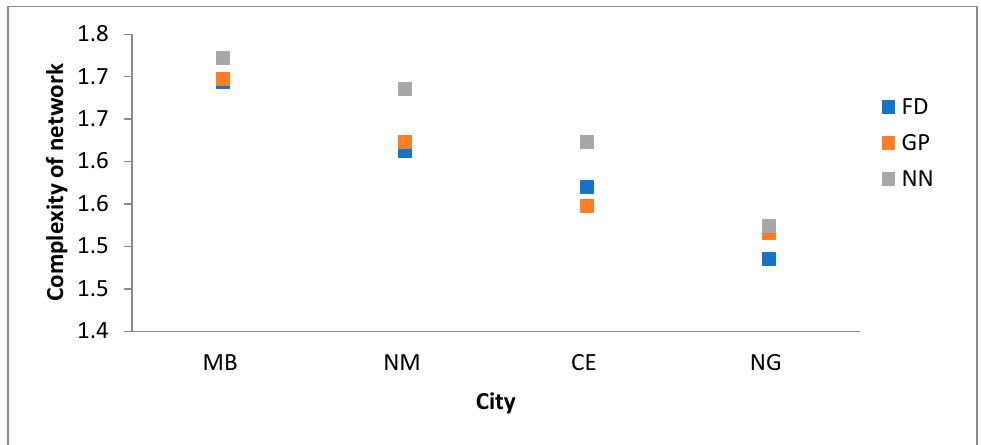
Table 2. Calculated and predicted complexity of the network.